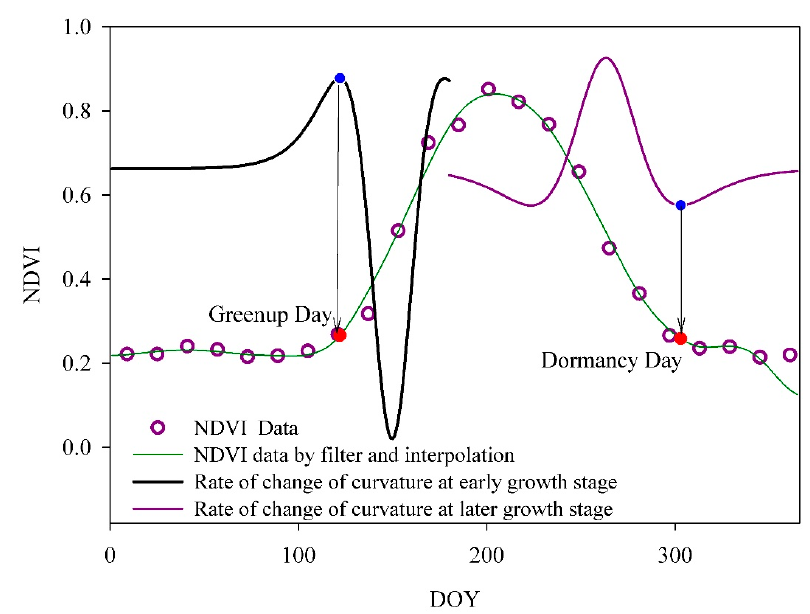
Figure 2. Sketch representing the identification of growing season.